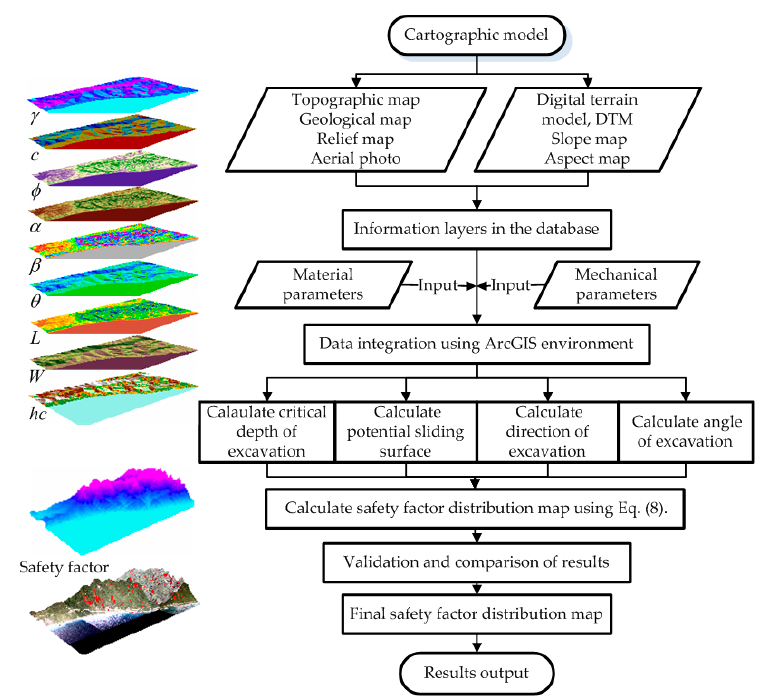
Figure 6. Flowchart showing the various phases of the performed methodology and all of the factors that were transformed into a grid-type spatial database. The safety factor distribution map and the description of types and units were stored in tables linked to the map using the built in relation data base management system of the GIS.